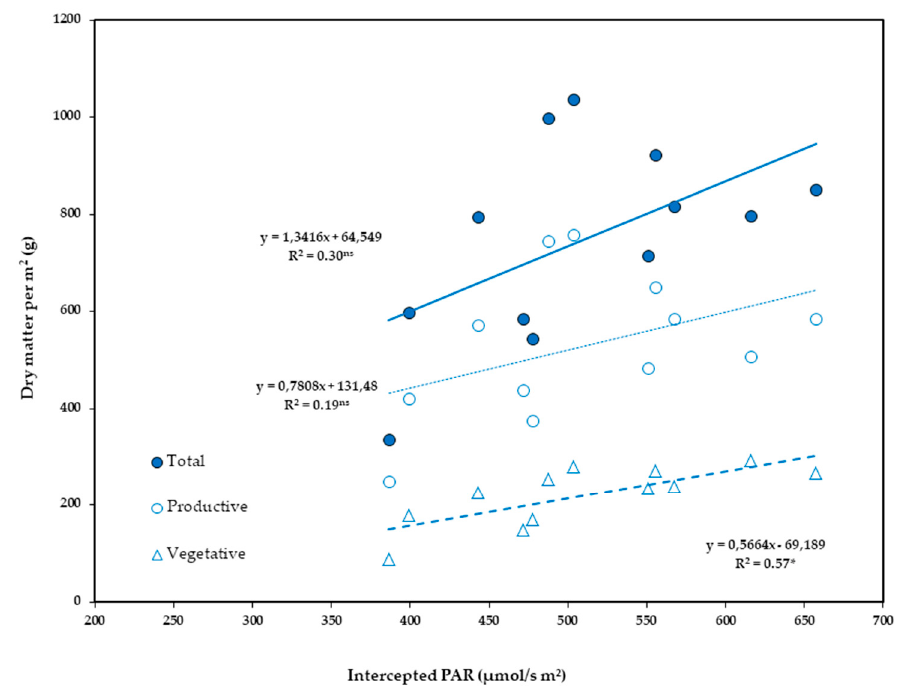
Figure 4. Relationship between seasonal PAR radiation intercepted by the vineyard (RI) and Total dry matter production (g/m 2 ), broken down into Productive dry matter and Vegetative dry matter. * indicates significance at p < 0.05; ns, not significant.